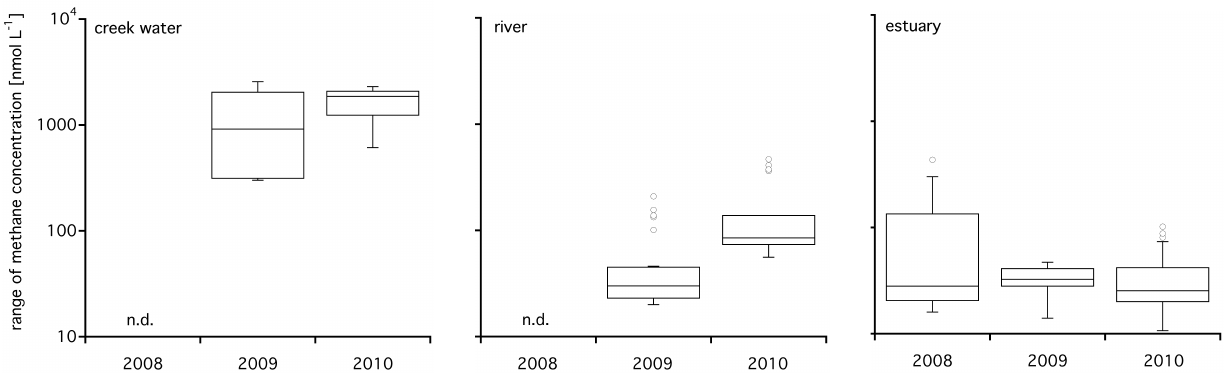
Fig. 3. Range of methane concentrations in creek water, in the Lena River and in the estuary of Buor-Khaya Bay for the years 2008, 2009 and